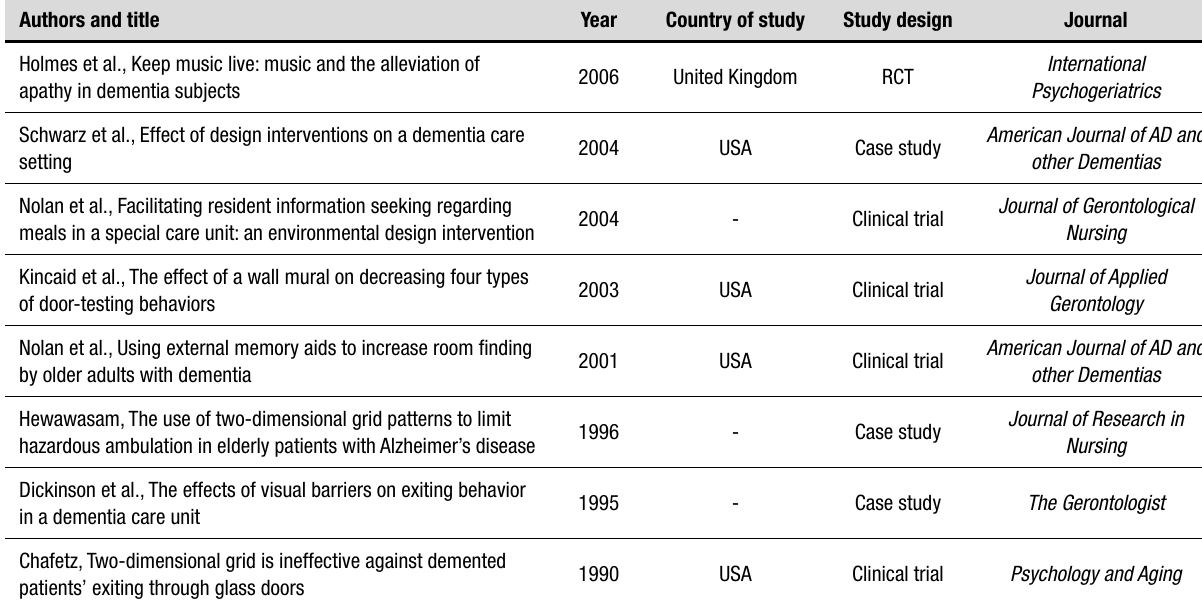
Table 1. Continuation.